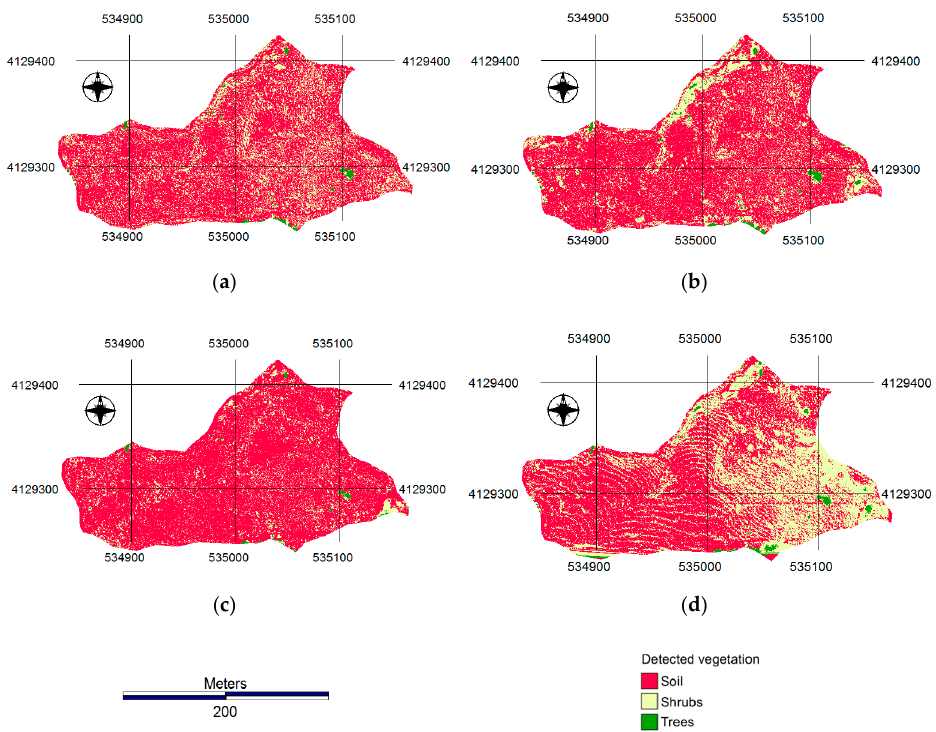
Figure 11. Vegetation areas detected by ( a ) unclassified dense point cloud (FFU), ( b ) classified dense point cloud (FFC), ( c ) multispectral vegetation index (FMI), and ( d ) cloth simulation filter (FCS).